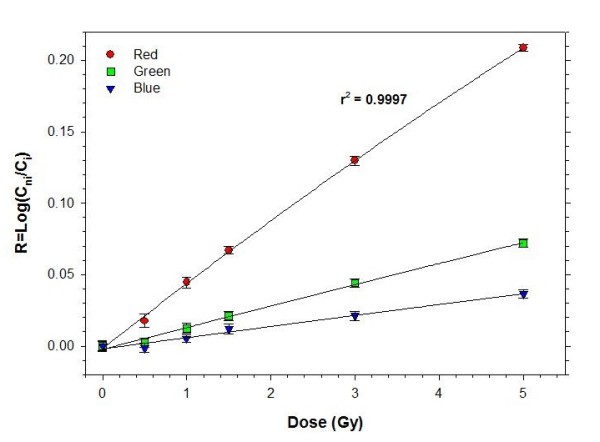
Calibration curve (Response vs. Dose). This curve shows the lineal response of the red, green and blue components (RGB mode) as function of the dose. Values are given as means ± SEM.